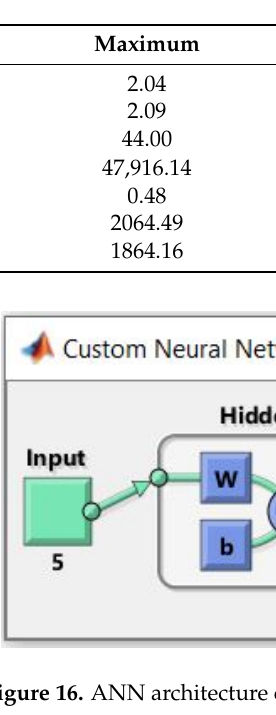
Table 5. Data to scale the inputs’ data.